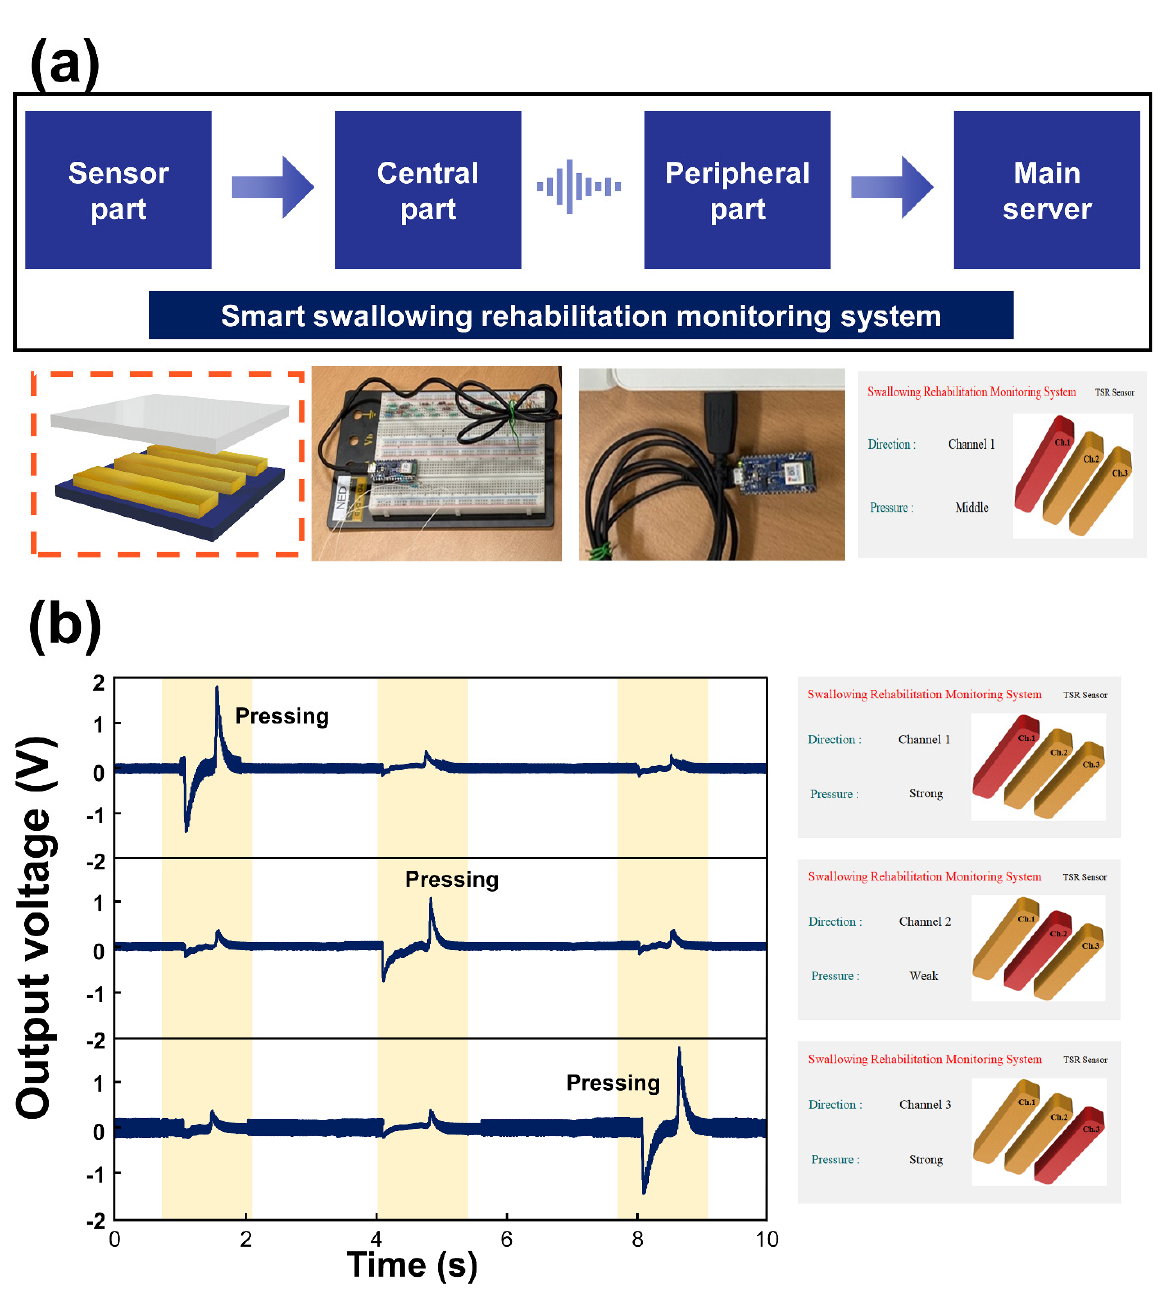
Figure 5. The smart swallowing rehabilitation monitoring system. ( a ) The schematic of the proposed smart swallowing rehabilitation monitoring system (SSRMS) and its components. ( b ) The electrical output generated from the SSRMS and the detecting results displayed on the monitor of the customized software.